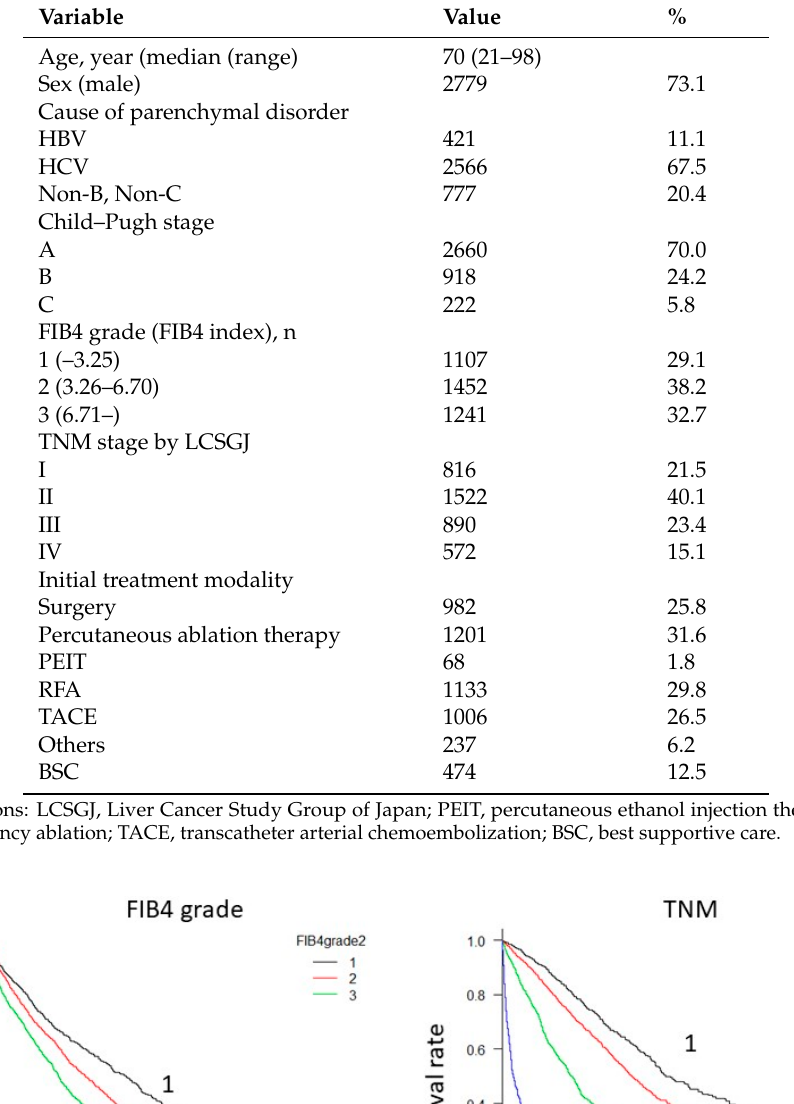
Figure 2. Overall survival rate according to ( a ) JIS score, ( b ) ALBI-T, and ( c ) FIB4-T (n = 3800) and Distribution of FIB4-T in ( d ) JIS score and ( e ) ALBI-T. The difference in survival between FIB4-T (0) and (1) was small compared with those in JIS score and ALBI-T, but prognosis of FIB4-T (0) was significantly better than prognosis of FIB4-T (1) ( p = 0.048). The p -value for each group was FIB 4-T 0– 1: 0.048, 1–2: <0.001, 2–3: <0.001, 3–4: <0.001, and 4–5: <0.001 (log-rank test). All p -values for each group in JIS score, ALBI-T were <0.001 (log-rank test). As prognostic models, good stratification was possible for all three systems ( p < 0.0001). Distribution of FIB4-T in JIS score and ALBI-T were as shown in (d) and (e).